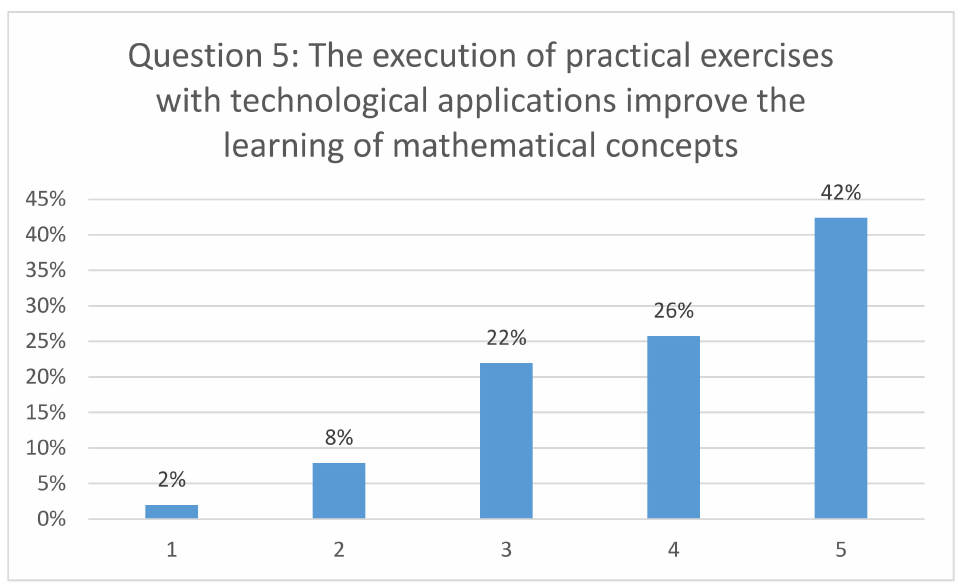
Figure 11. Answers to question 5: the execution of practical exercises with technological applications improve the learning of mathematical